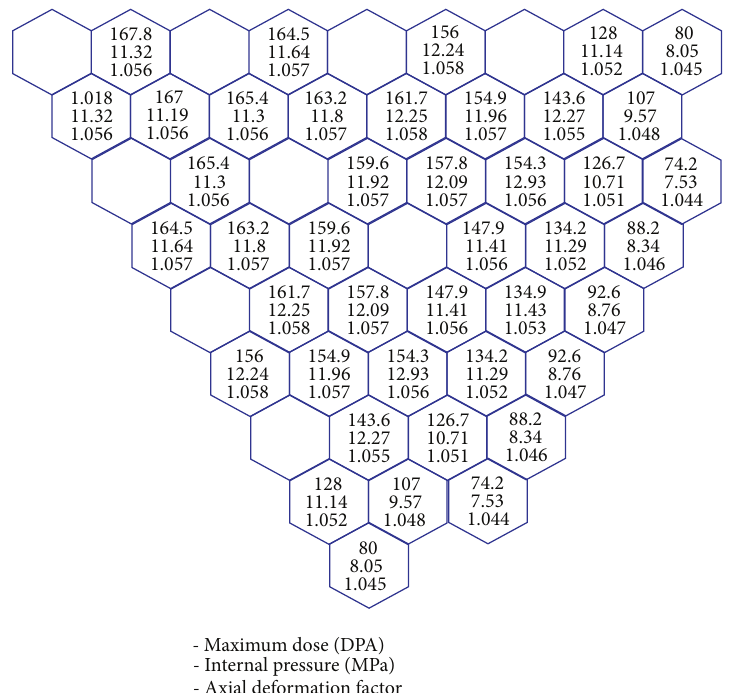
Figure 15: Assembly-wise maximum cladding dose, rod internal pressure, and average axial deformation factor at